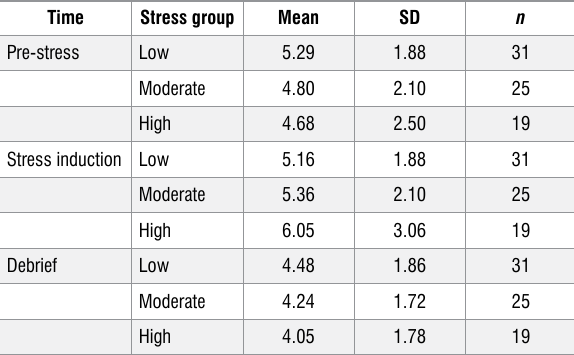
Table 5: Descriptive statistics for self-report stress in Experiment 2 at three time points: pre-stress, stress induction and debrief Time Stress group Pre-stress